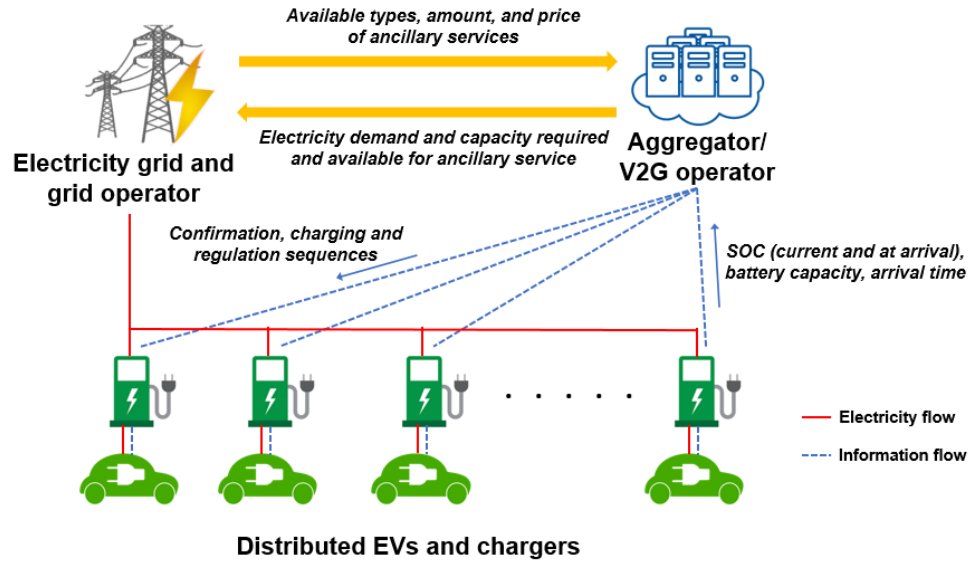
Figure 8. A simplified data flow and architecture of the V2G system highlighting the role of an aggregator.